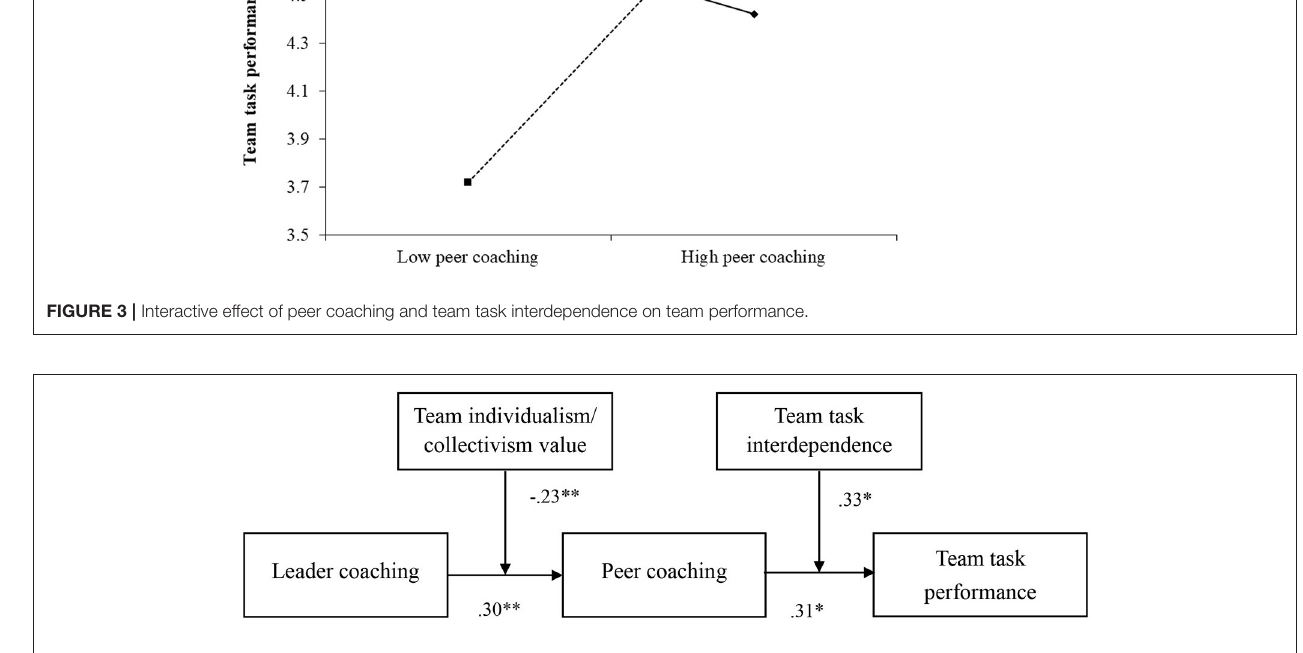
FIGURE 4 | Results of path analysis. *p < 0.05, **p <